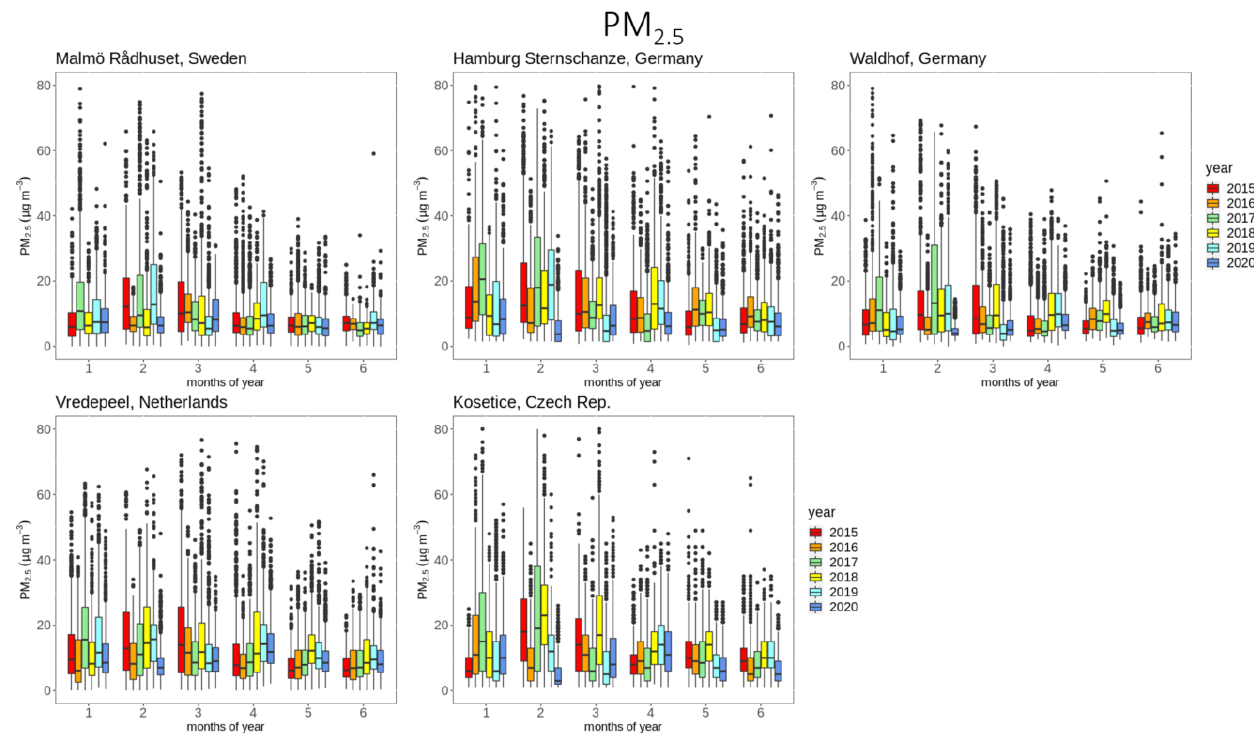
Figure 8. Observed monthly concentrations of NO 2 , O 3 and PM 2 . 5 at Waldhof (Germany), Vredepeel (the Netherlands), San Rocco (Italy), Košetice (Czech Republic), Malmö (Sweden) and Hamburg (Germany). The median is displayed within the central boxes which span from the 25th percentile to the 75th percentile, called the interquartile range of the underlying frequency distributions. For NO 2 and PM 2 . 5 these distributions are based on hourly measurements at the different stations and for O 3 on daily 8h maximum values. The whiskers above and below the central boxes indicate the largest and the smallest value within 1.5 times the interquartile range, respectively. Dots denote values outside these ranges. PM 2 . 5 was not available at San